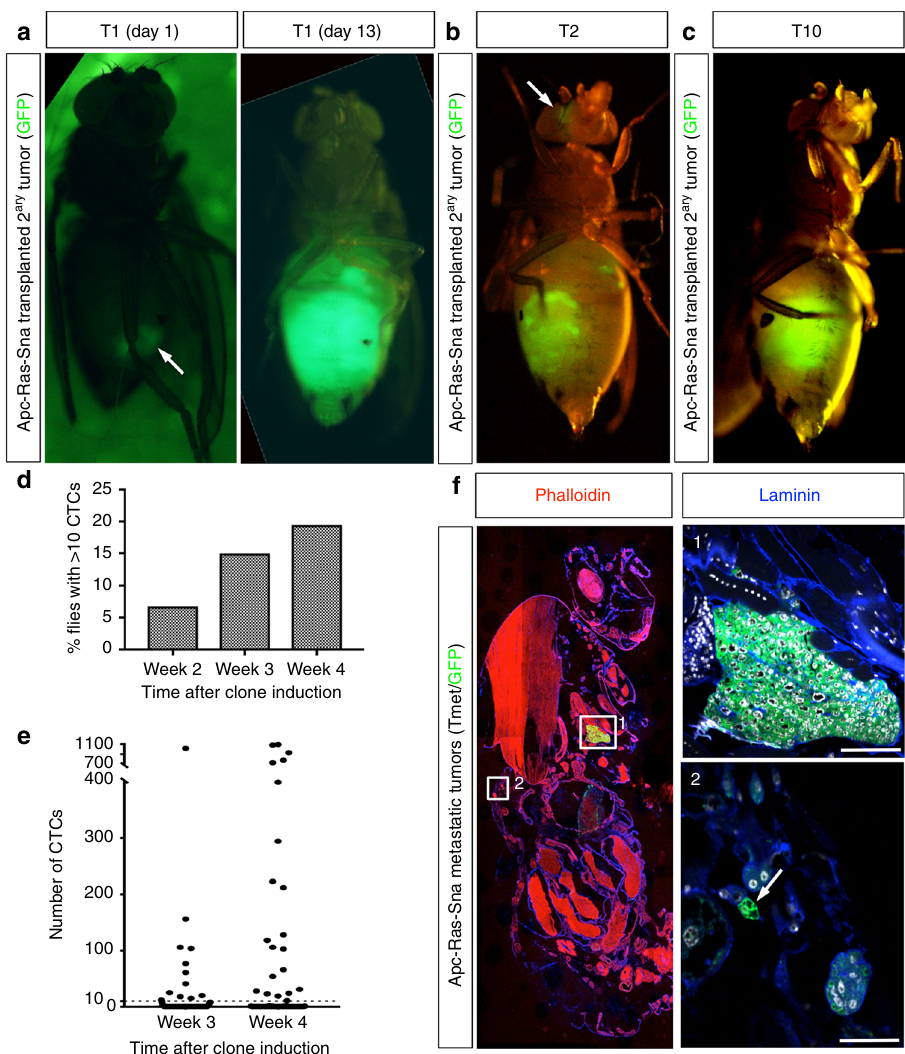
Fig. 2 Analysis of metastases formation through transplant and circulating tumor cell (CTC) assays. a A piece of a green fl uorescent protein (GFP)-labeled metastatic tumor (TMet; arrow) implanted into the abdomen of an adult host grows to fi ll up the entire abdomen of the host fl y in just 13 days, rapidly killing the host. b , c TMets continue to grow during serial implants. In early implants small tumor colonies were seen distant to the abdomen ( b , arrow), but by T10 TMets became more compact in size and localized in the abdomen ( c ). d , e Levels of luciferase activity were measured from the hemolymph extracted from individual fl ies. d The percentage of fl ies found with over 10 CTCs in their hemolymph, n = 59 (week 2), n = 80 (week 3), n = 108 (week 4). e The number of CTCs found in the hemolymph of individual fl ies, measured at 3 and 4 weeks after clone induction. The threshold of cells considered signi fi cant (10) is displayed by a dashed line. f Sagittal section from an Apc-Ras-Sna fl y with a macrometastases in the thorax (1) and small doublets of GFP + cells near the cuticle of the abdomen (2, arrow). Scale bars: (1) 50 µ m and (2) 25 µ